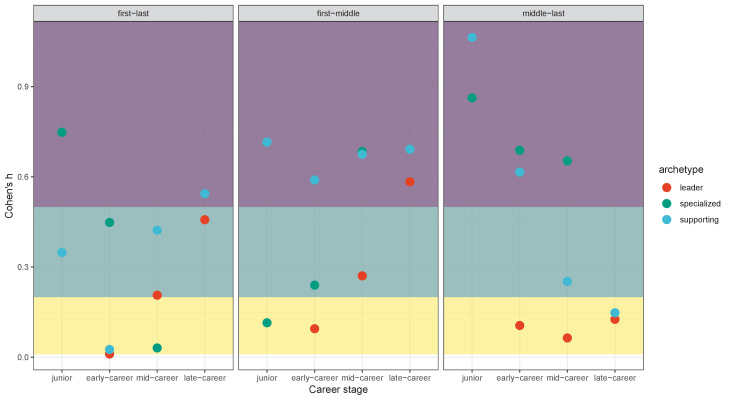
Effect sizes for differences in proportions by author position and archetype at each stage.Colored areas provide descriptive interpretation. Yellow indicates small effect size, green indicates medium and purple indicates large effect. Values for specialized and supporting and the junior stage and leader and supporting at the late-career are overlapped.